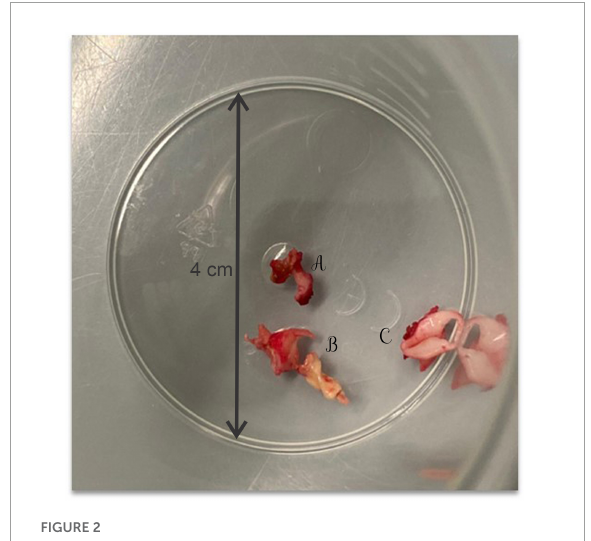
FIGURE2 The calcified mass extracted intraoperatively from the left subclavian artery (A) , the aortic arch (B) , and the left common carotid artery (C) .